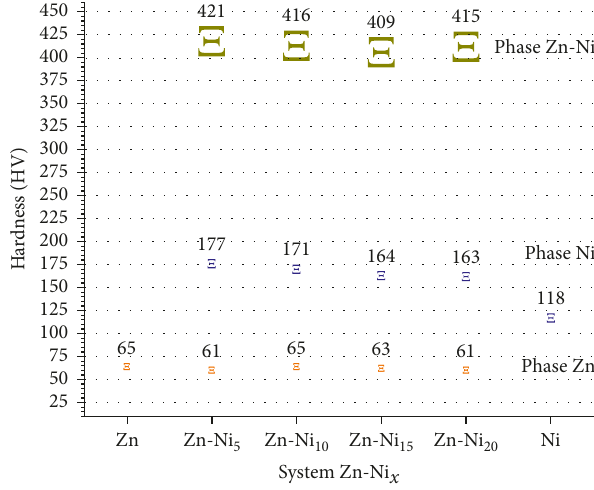
Figure 13: Zn and Ni behavior on microhardness properties of the Zn-Ni x sintered powder alloy